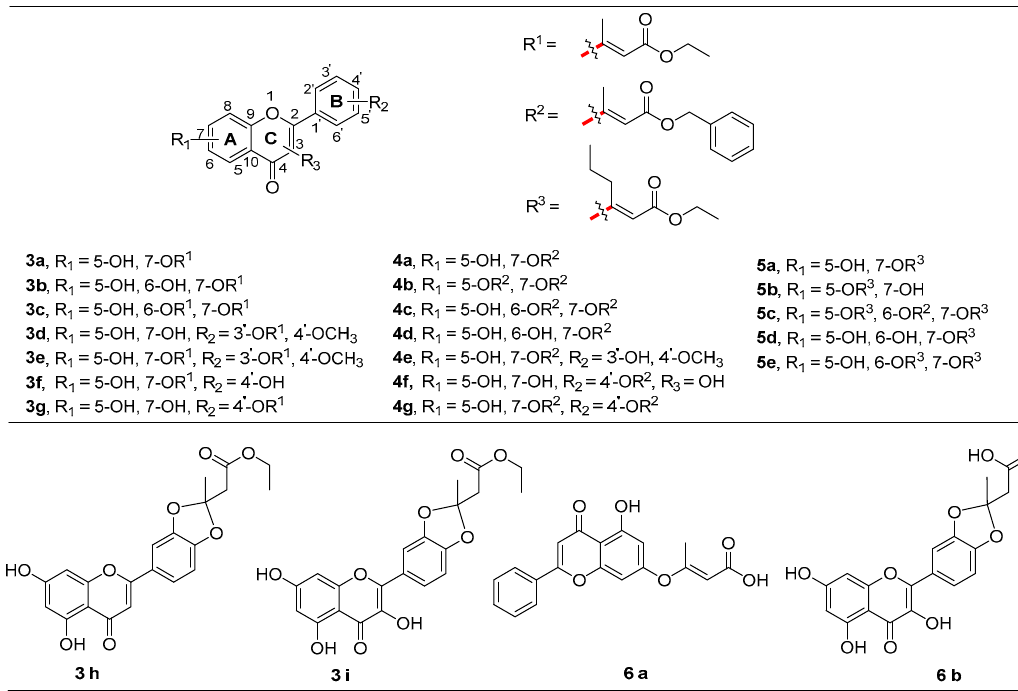
Figure 2. Substrate scope of flavonoids and allenes.